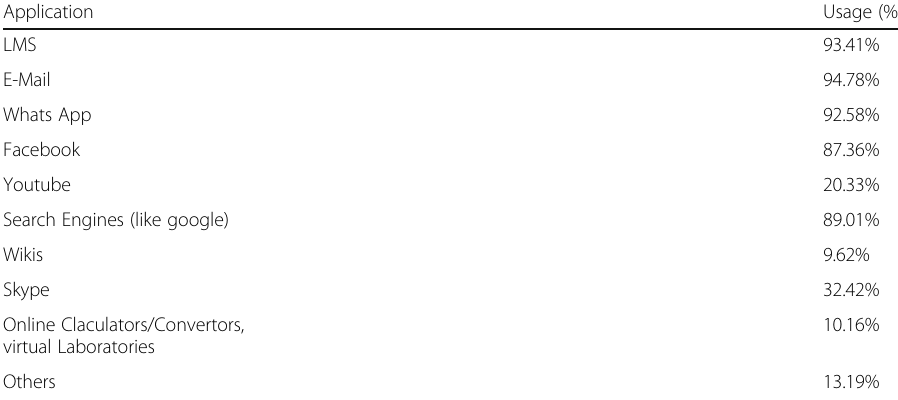
Table 5 Top applications used for teaching and learning